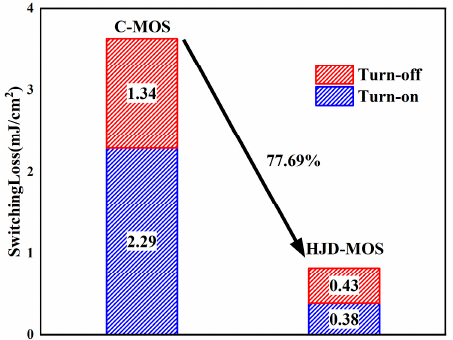
Figure 10. ( a ) Double pulse test circuits. ( b ) Turn-on and ( c ) turn-off waveform of the C-MOS and the proposed structure.